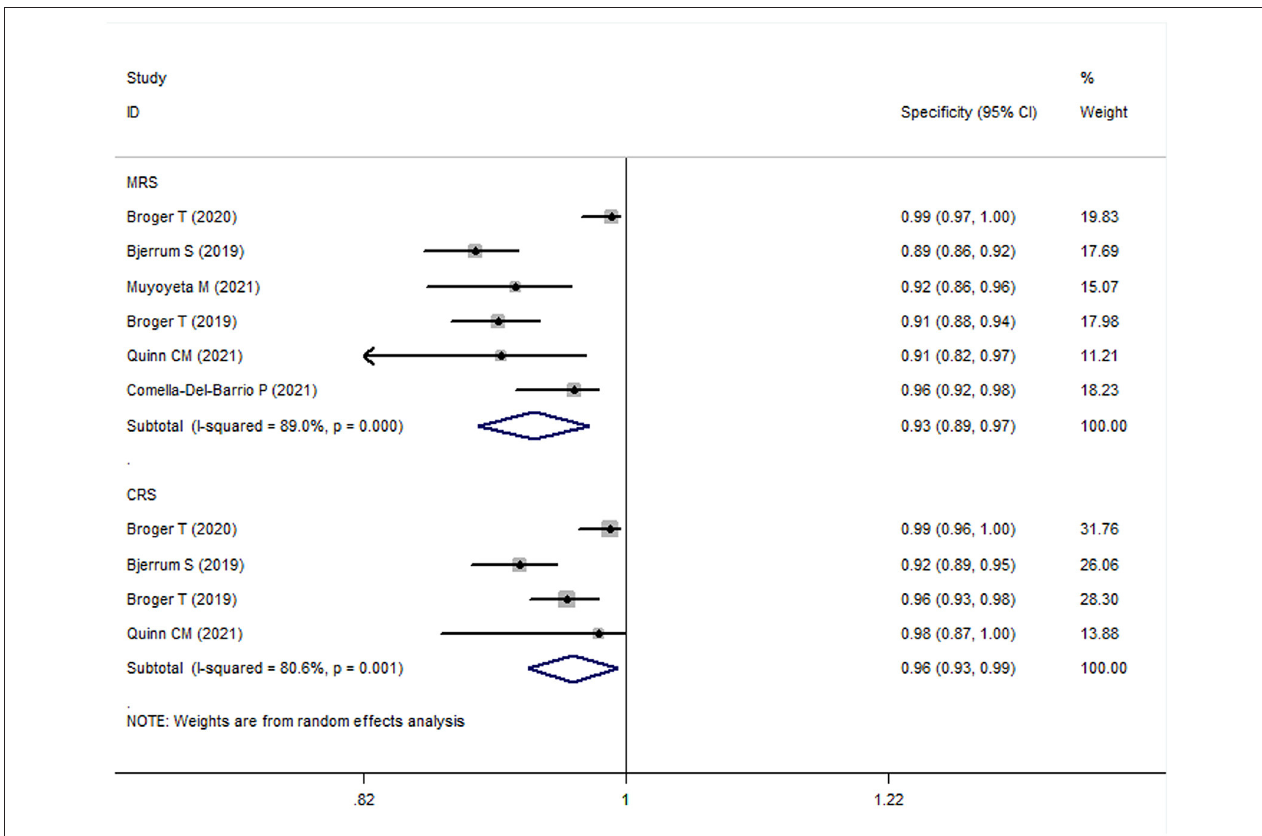
FIGURE 4 | The meta-analysis results of the specificity of FujiLAM in the diagnosis of adult patients with